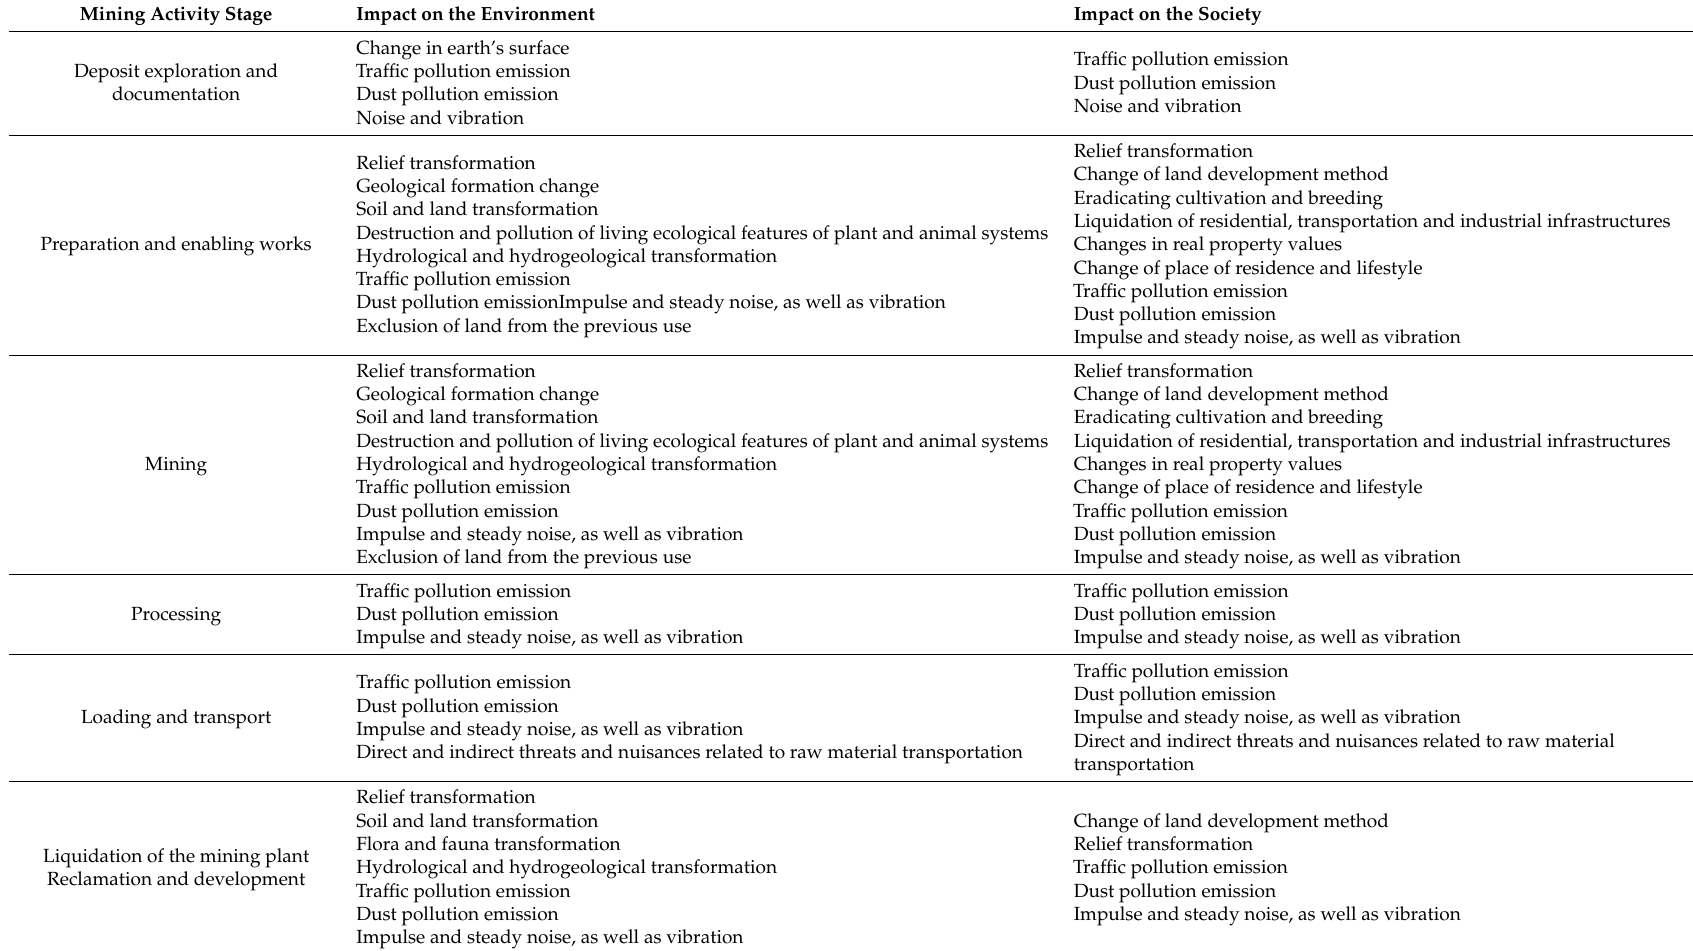
Table 1. Mining activity stages and their impact on the environment and